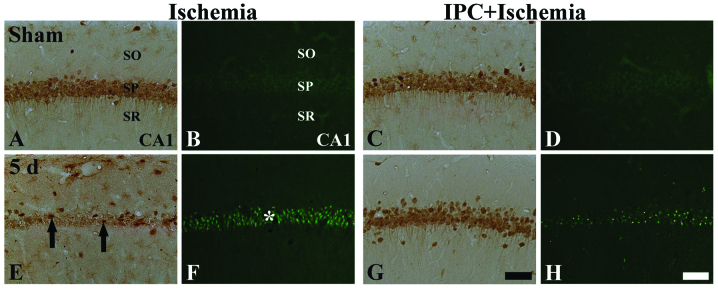
NeuN immunohistochemistry (the first and third longitudinal columns) and F-J B histofluorescence staining (the second and fourth longitudinal columns) in the CA1 region of the ischemia-operated (left 2 columns) and IPC + ischemia-operated (right 2 columns) groups at (A-D) sham and (E-F) 5 days (5 d) following ischemia-reperfusion. In the sham-operated group, many NeuN+ neurons, but no F-J B+ cells were observed in the stratum pyramidale (SP). In the ischemia-operated group, a few NeuN+ (black arrows) and many F-J B+ (asterisk) cells were detected in the SP at 5 days post-ischemia. However, in the IPC + ischemia-operated group, abundant NeuN+ and few F-J B+ cells were detected in the SP at 5 days post-ischemia. NeuN, neuronal nuclei; F-J B, Fluoro-Jade B; CA1, region I of hippocampus proper; IPC, ischemic preconditioning; SO, stratum oriens; SR, stratum radiatum. Scale bar, 50 μm.